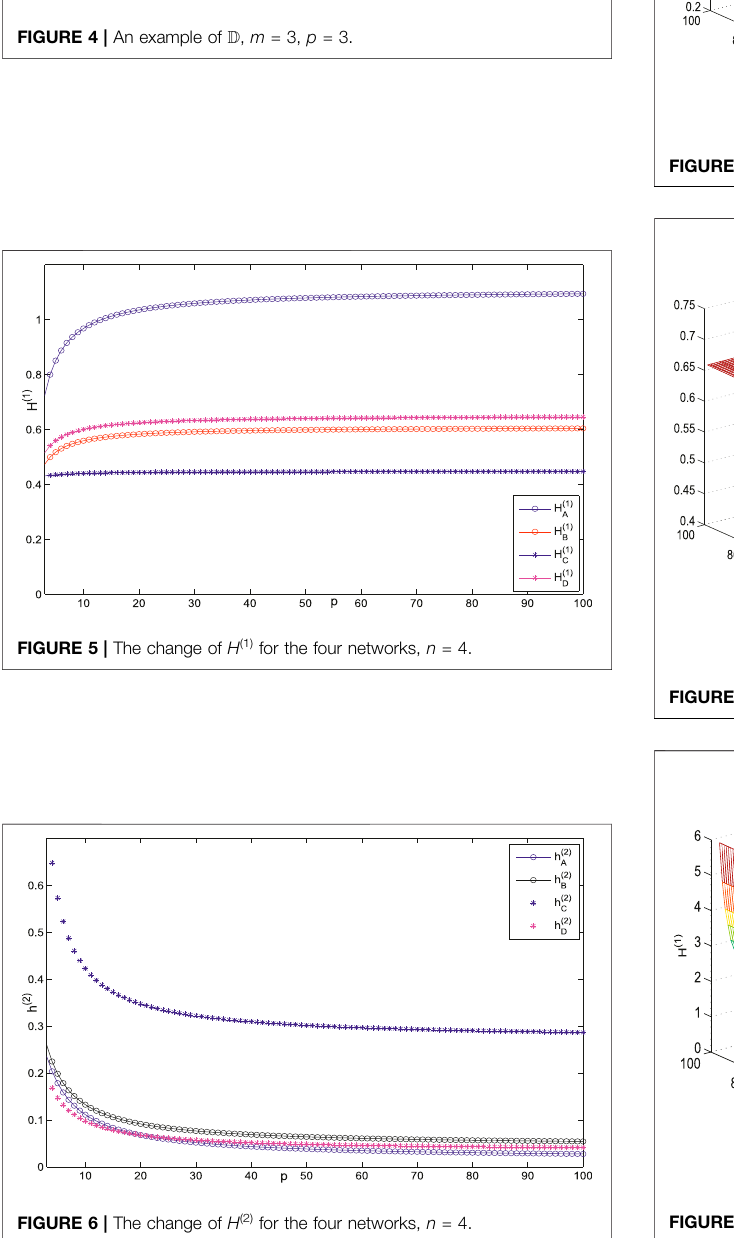
FIGURE 6 | The change of H (2) for the four networks, n (cid:1) 4.